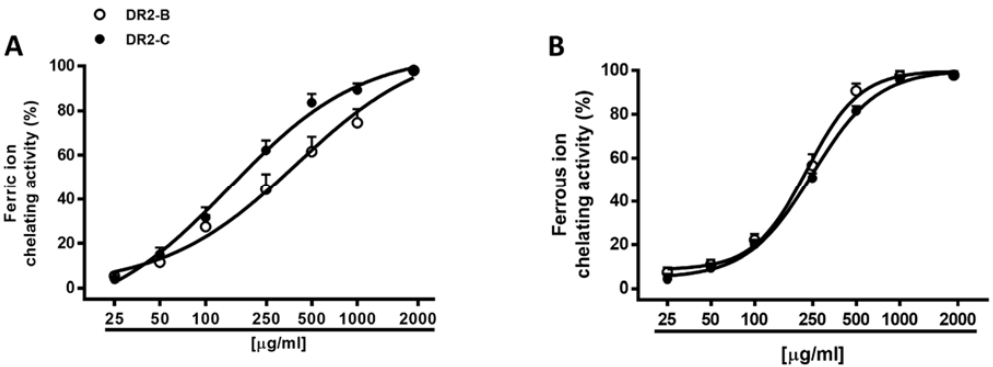
Figure 5. Chelating activity of DR2B and DR2C extracts against ferric ( A ) and ferrous ( B ) ions. Data are mean ± SE from two independent experiments, each one performed in 3 technical replicates ( n = 6). The antioxidant capacity of eggplant is ranked in the top ten of 120 different vegetables, although some differences can occur due to variety, fruit shape, and size and methodology [25]. Jung et al. [40] and Nisha et al. [41] reported the DPPH radical scavenging and metal chelating properties of eggplant peel, while Kaneyuki et al. [67] found strong scavenging effects against hydroxyl radical generation. Different extracts from fresh aubergine berry peel produced radical scavenging effects against DPPH and hydrogen peroxide, and metal chelation, which were mainly related to phenolics [42]. Singh et al. [49] also described the ability of skin eggplant to inhibit the cupric ion ‐ mediated lipoperoxidation. Likewise, aubergine berries exhibited radical scavenging and chelating activities [26,68]. Mennella et al. [33] also suggest the involvement of several bioactive constituents to the scavenging activity of NAS ‐ type (containing nasunin as major anthocyanin) and D3R ‐ type (containing delphinidin ‐ 3 ‐ rutinoside as major anthocyanin) eggplant varieties. Higher antioxidant capacities were also reported for semi ‐ purified peel extracts from D3R ‐ type and NAS ‐ type aubergine berries respect to the purified D3R and NAS anthocyanins [69], thus confirming that other phytochemicals besides anthocyanins are involved in the antioxidant activity of the phytocomplex. Accordingly, our results suggest that several components of the DR2B and DR2C phytocomplex can contribute to the described antioxidant activity, acting by direct (by neutralizing DPPH, ABTS, and hydroxyl radical) and/or indirect (as chelators of ferrous and ferric ions) mechanisms. Among phytochemicals, the antioxidant properties of chlorogenic acid and the esters formed between caffeic and quinic acids are widely reported [70]. On the other hand, the radical scavenging and chelating effects of different polyphenols and anthocyanins have been published [28,29,37,71]. Particularly, delphinidin glucosides have shown to possess the strongest scavenging activity against superoxide anion and peroxynitrite, and NAS has been demonstrated to be a potent superoxide anion radical scavenger [69]. However, along with polyphenols and anthocyanins, a possible role of other unidentified phytochemicals in the biological activity of DR2 eggplant peel cannot be excluded.